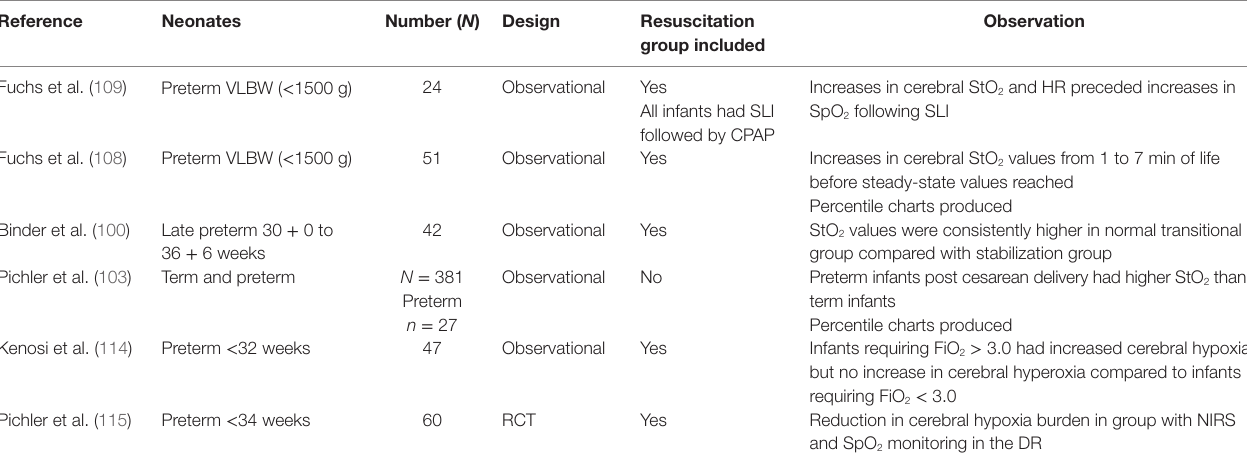
TABLe 2 | Summary of preterm DR NiRS